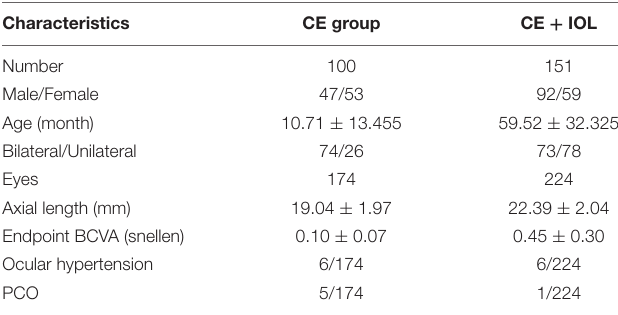
TABLE 1 | The characteristics of real-world data of enrolled patients with